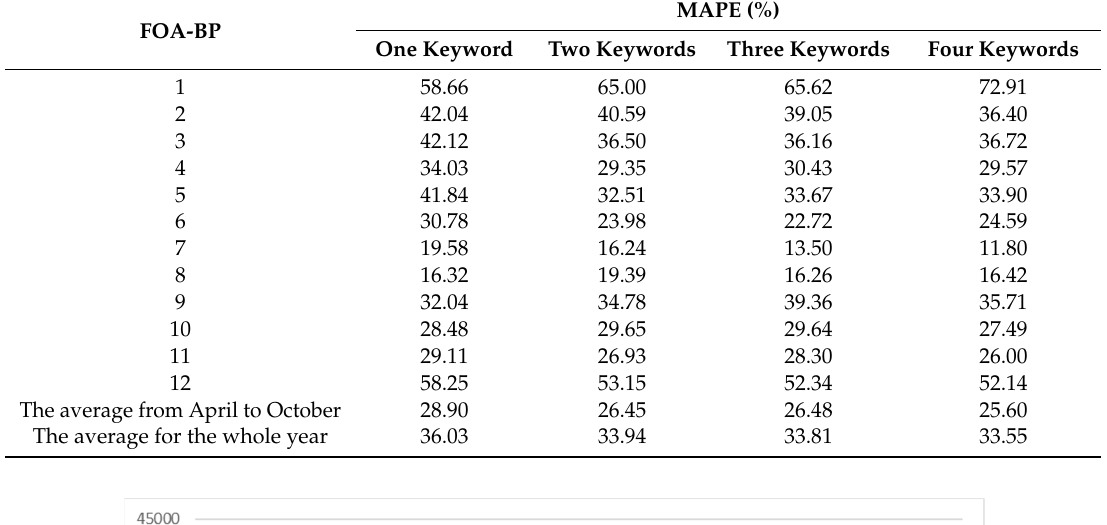
Table 7. Results of FOA-BP model including the web search data with 1–4 keywords as input. FOA-BP